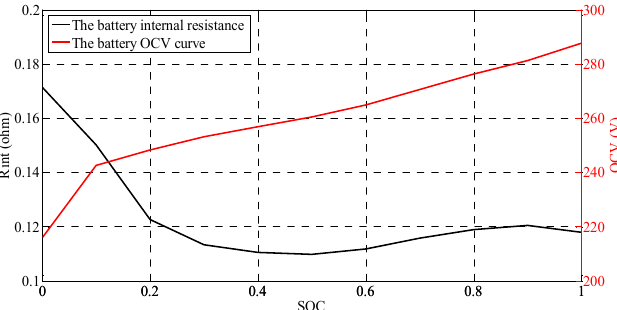
Figure 3. The battery internal resistance and the open circuit voltage (OCV) curve with respect to state of charge (SOC).